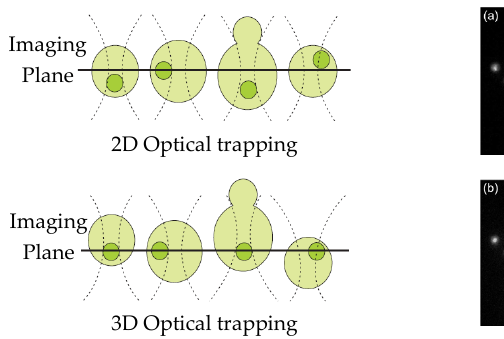
Figure 9. Automated focusing for nuclei of multiple cells [117] : ( a , b ) GFP images, ( c , d ) bright-field images, ( a , c ) trapping points on the same plane, and ( b , d ) nuclei on the same plane. The incorporation of HOT also enhances the performance of Raman spectroscopy